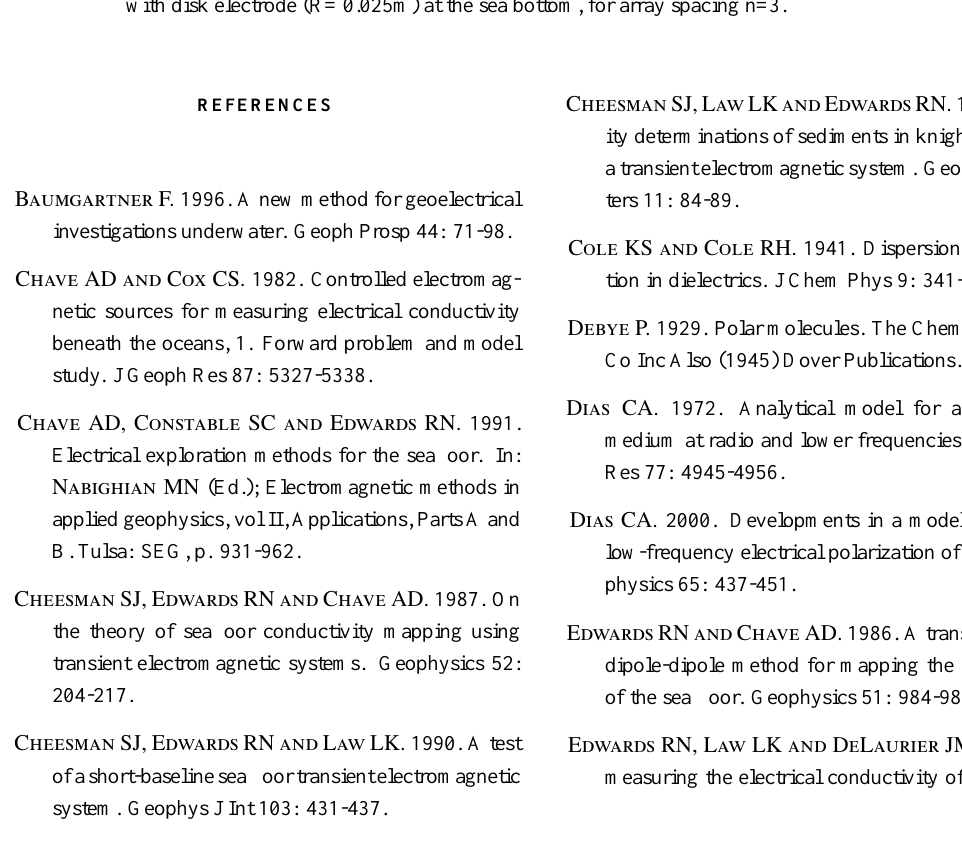
Fig. 11 – Comparison between the experimental and theoretical apparent conductivity (S/m) with disk electrode (R= 0.025m) at the sea bottom, for array spacing